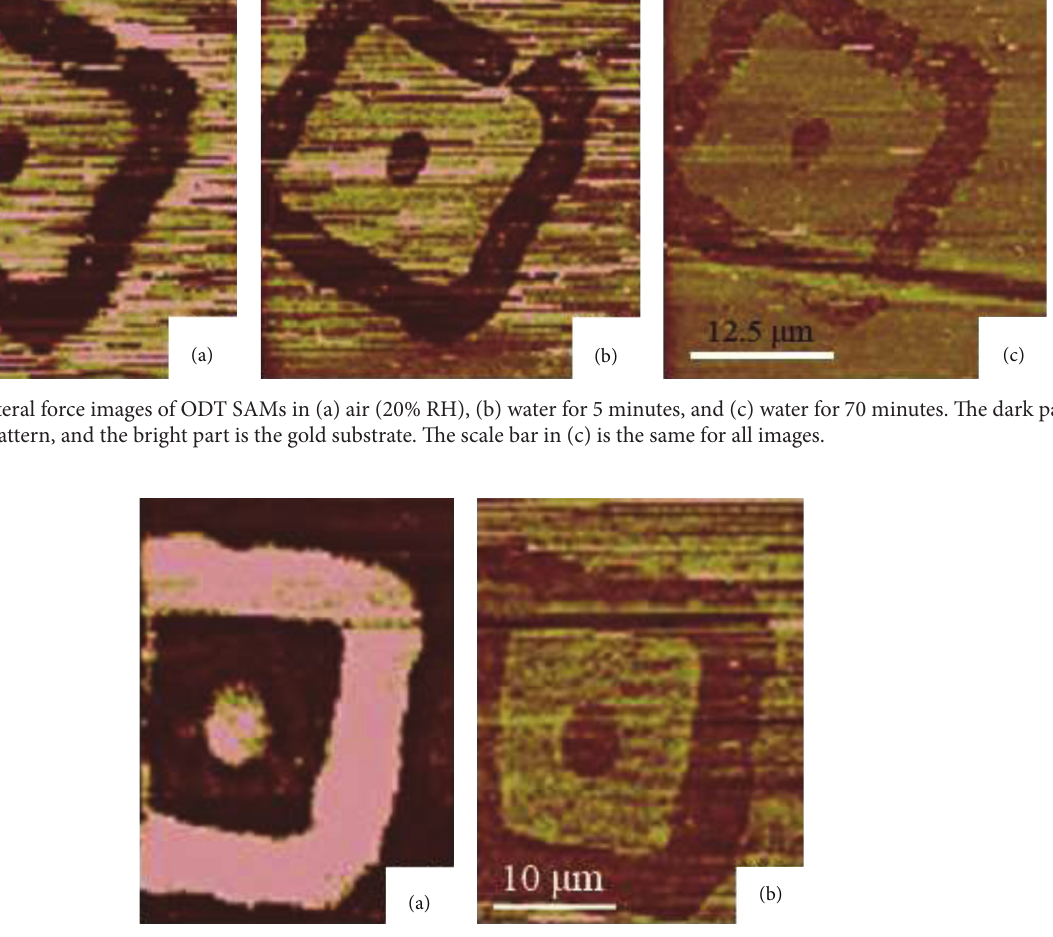
build up a thin layer at lower speed on the SAMs